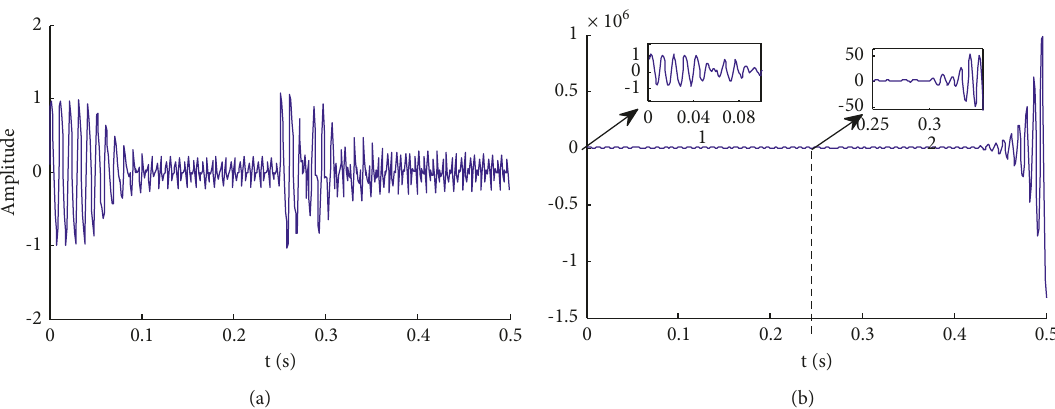
Figure 6: Curves of reference signal changing with time. (a) Normalization algorithm. (b) Sinusoidal variable step-size